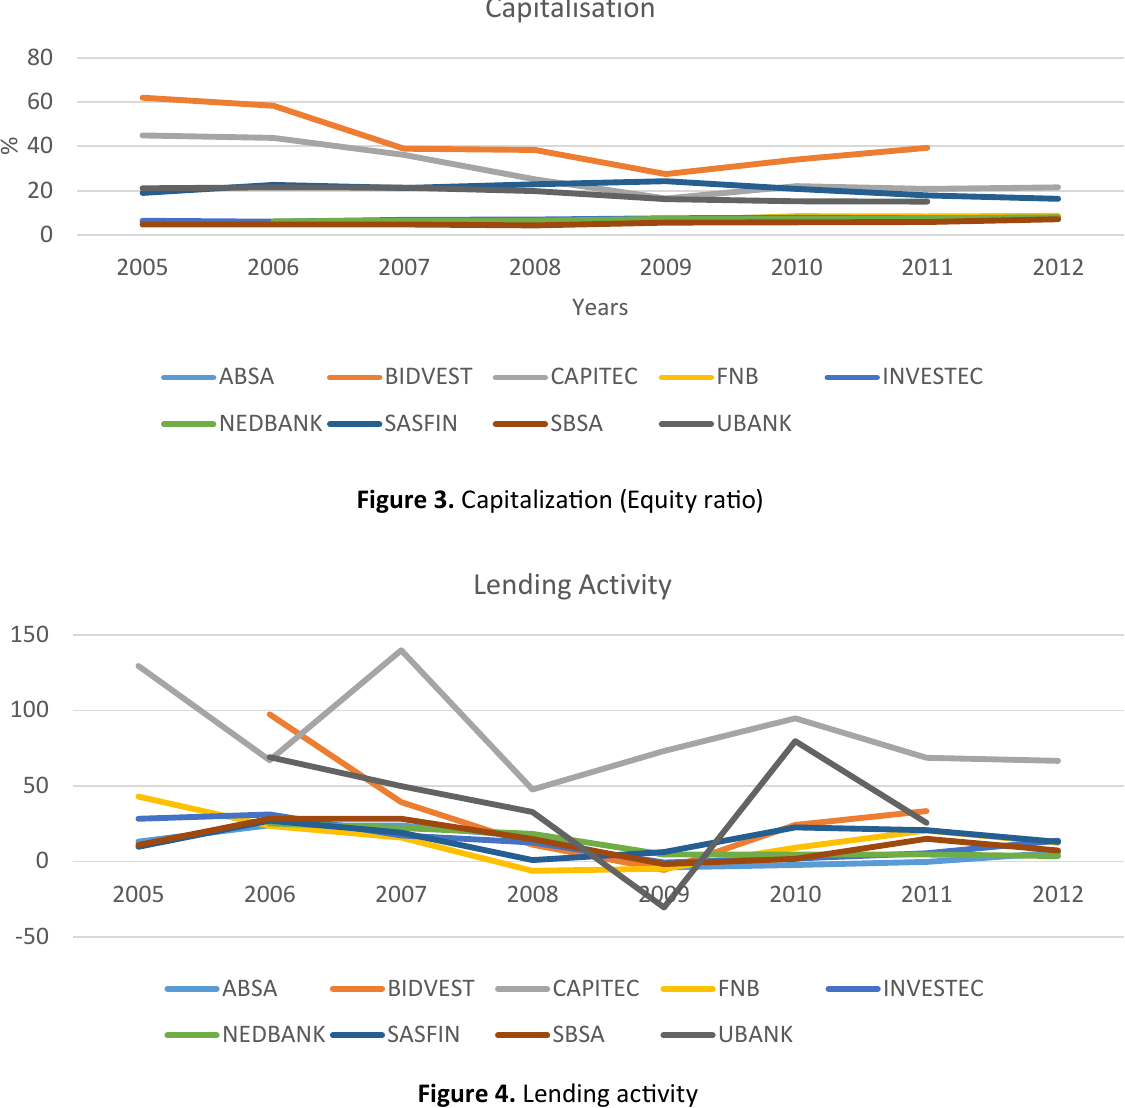
Figure 4. Lending